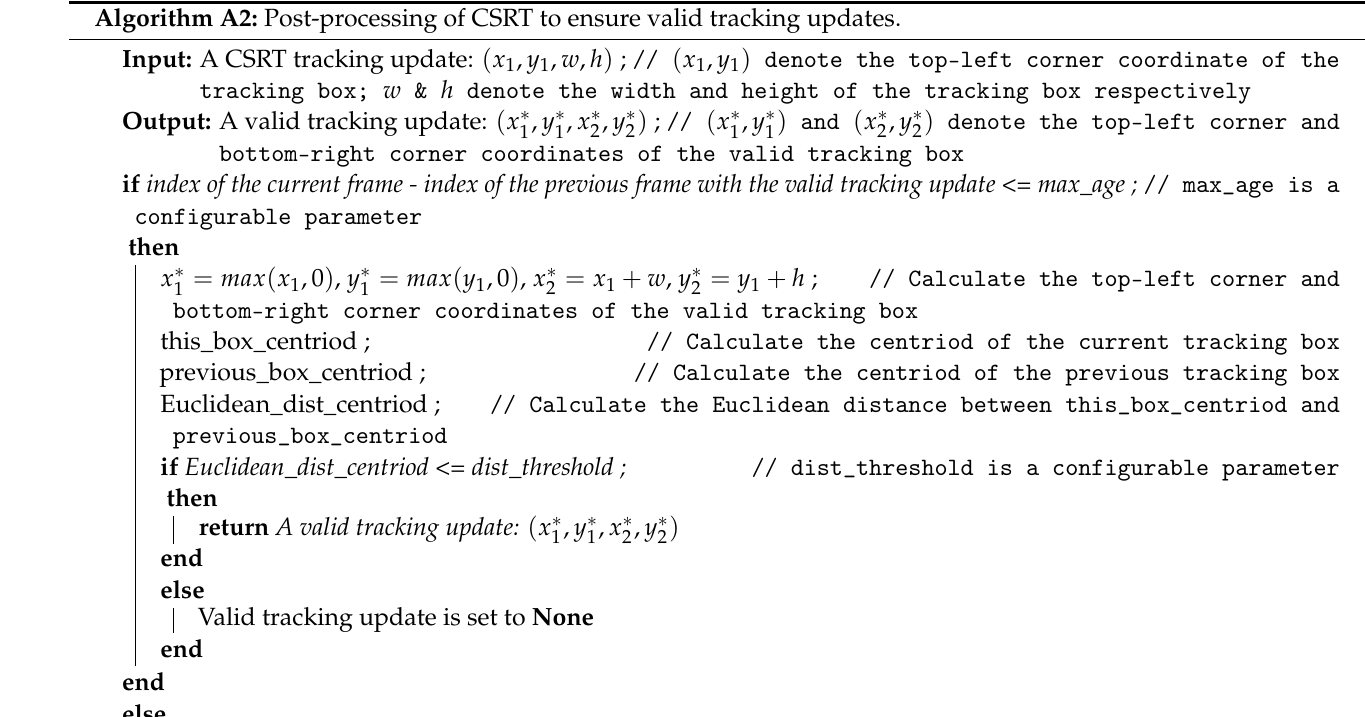
Algorithm A2: Post-processing of CSRT to ensure valid tracking